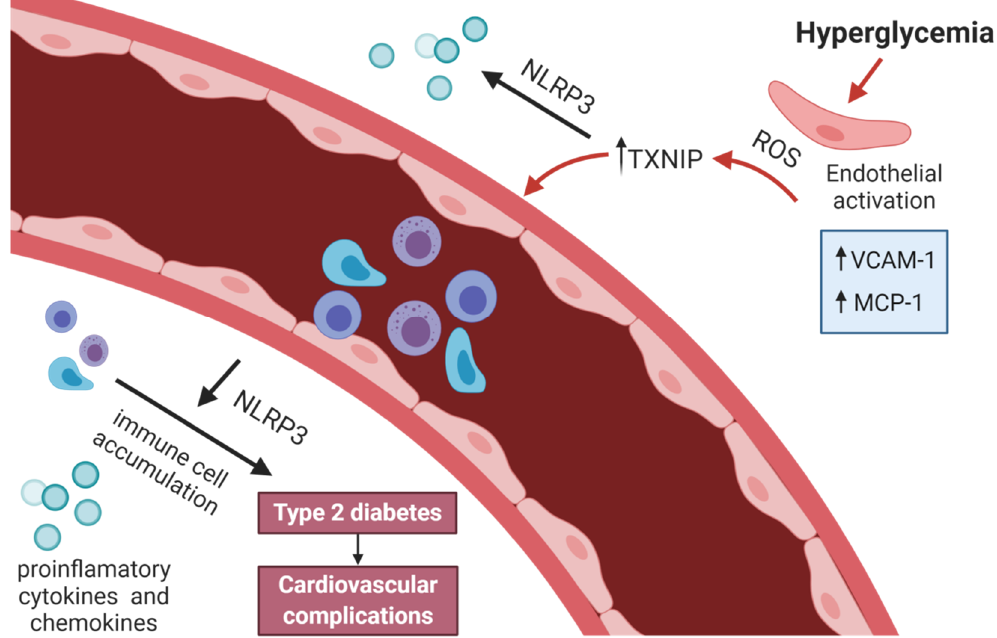
Figure 1. Links between NLRP3, endothelial dysfunction, and type 2 diabetes.